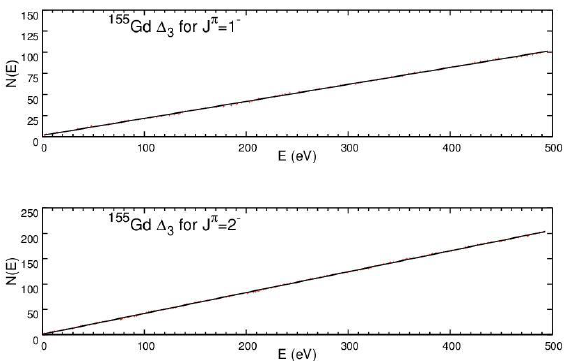
Fig. 8. Cumulative number of energy levels in the energy 0 eV to 500 eV for 155 Gd.